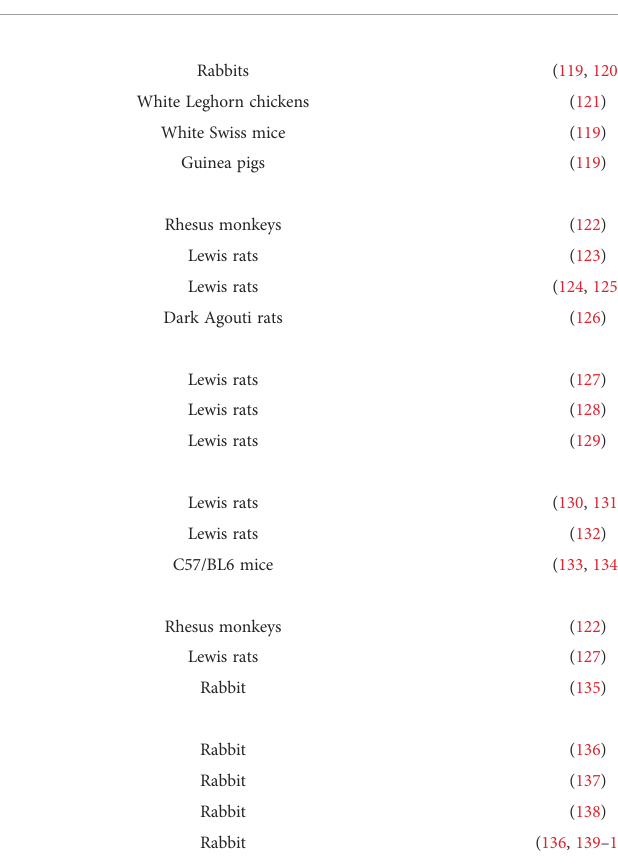
TABLE 3 Development of models of actively induced EAN. Antigen Animal